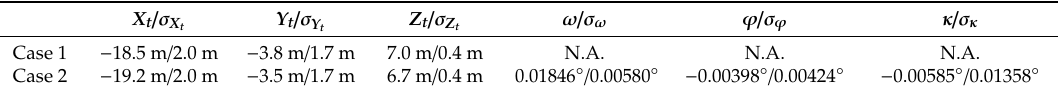
Table 2. Transformation parameters and its standard deviations of point-to-surface matching.